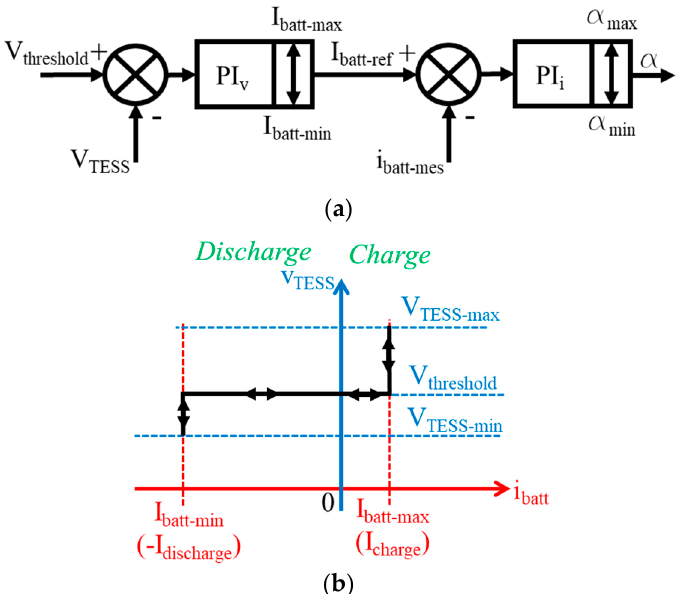
Figure 4. Control of DC/DC converter based on two cascaded loops: ( a ) voltage and current control loops; ( b ) voltage (V TESS ) – current (i batt ) characteristic.